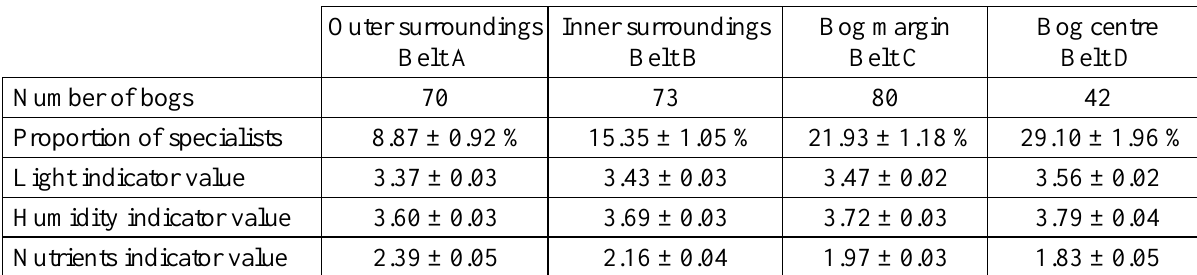
Table 3. Site conditions in Belts A, B, C and D of the bogs studied.